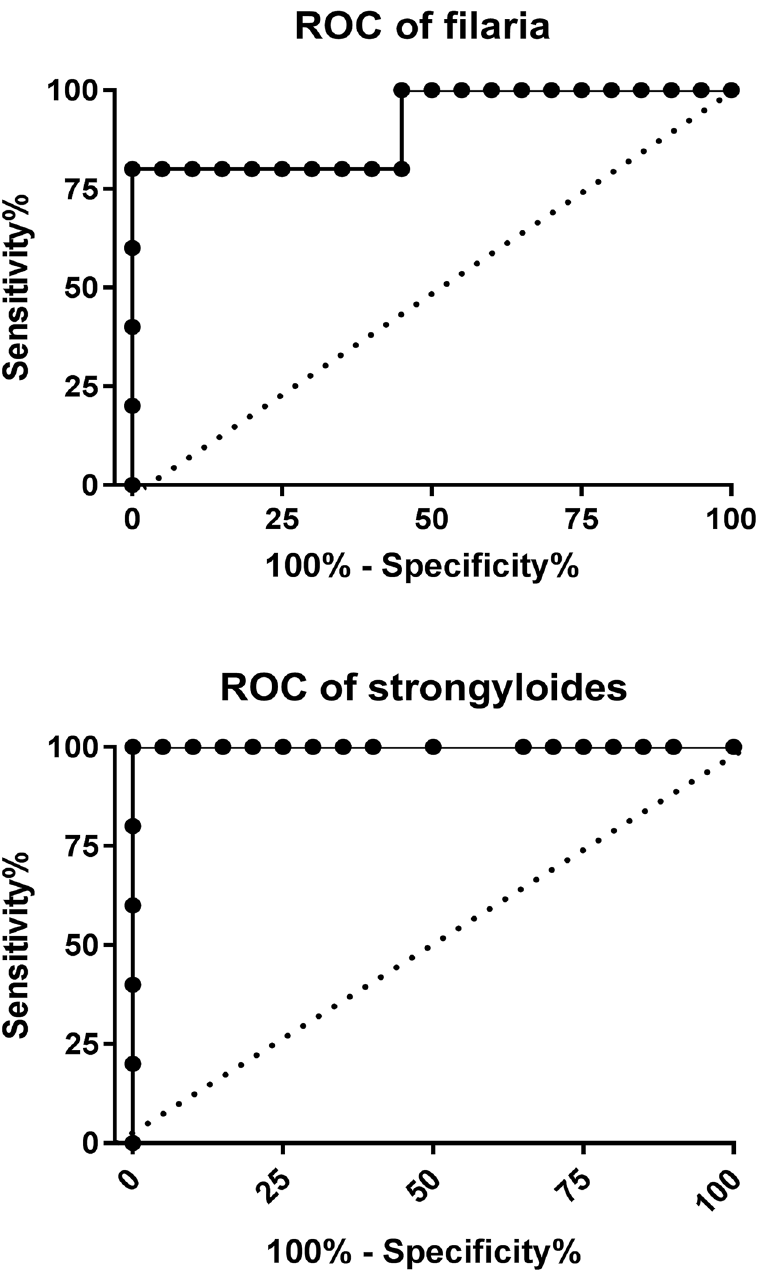
Fig 1. Receiver operating curves for filaria (a), Strongyloides (b) using sera from US naïve donors as negative controls and from parasitologically proven infected donors as positive controls. The analysis suggested good performance characteristics for both assays, with optimal cutoff values for seropositivity of 107 for filaria and 170 for Strongyloides.